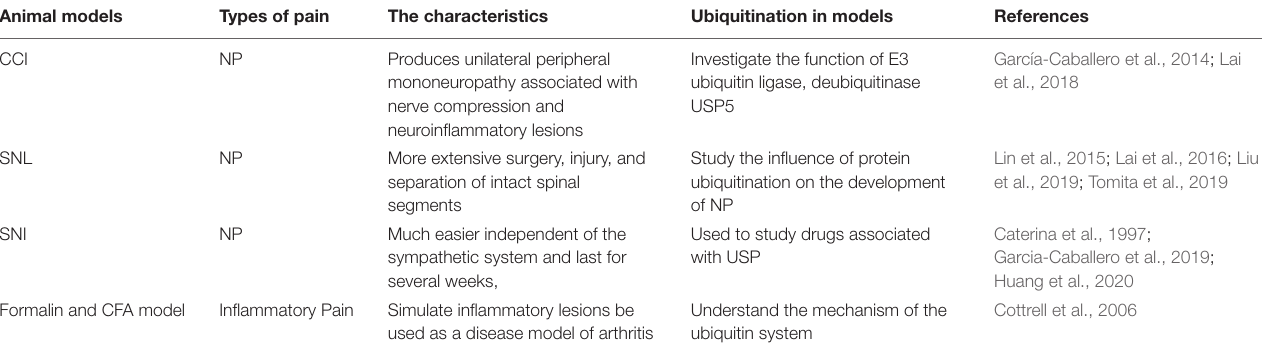
TABLE 1 | Ubiquitination in animal models of chronic